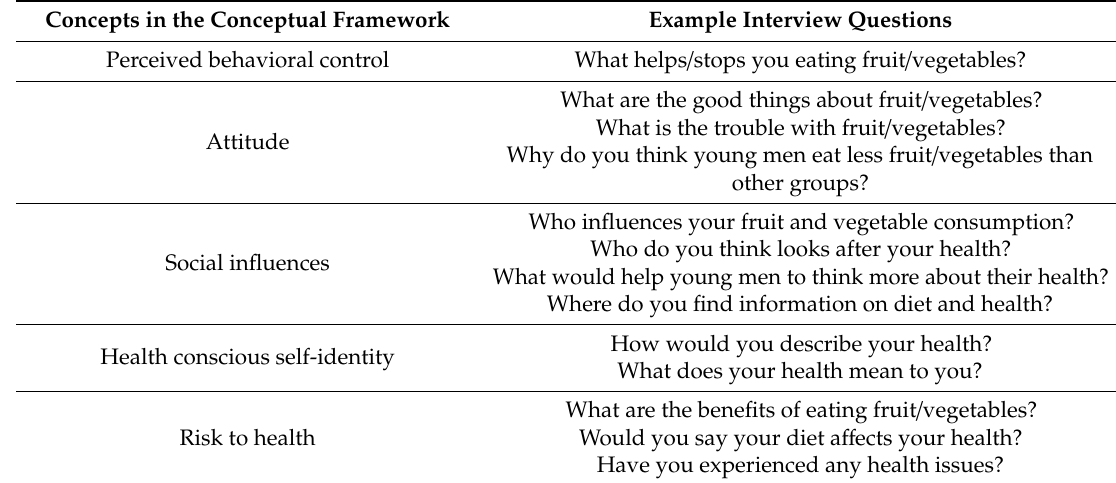
Table 2. Interview guide for the focus